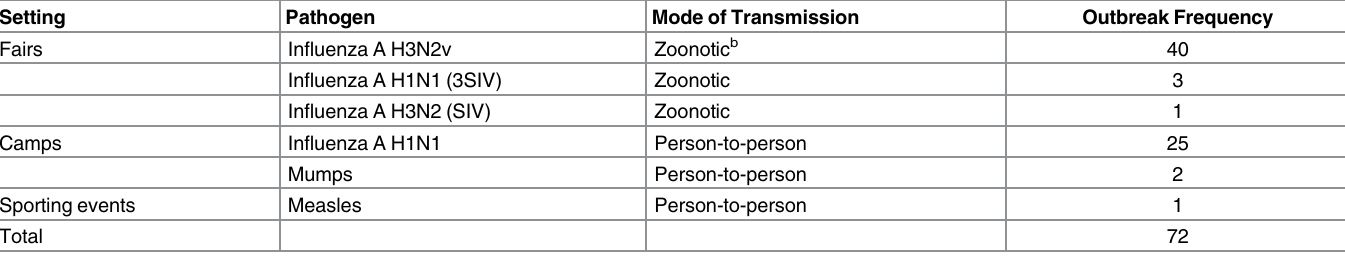
Table 3. Frequency of mass gathering-related respiratory disease outbreaks identified from the published literature a by setting, pathogen, and mode of transmission, January 1, 2005 – December 31, 2014.